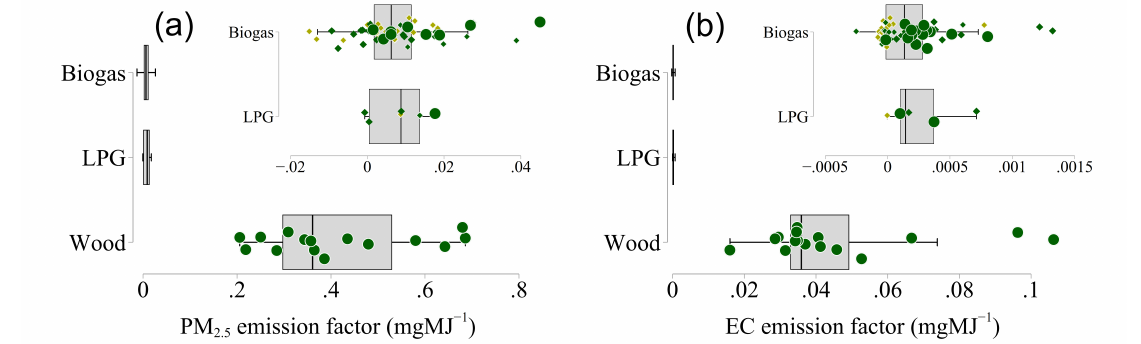
Figure 2. Box plots of PM 2.5 ( a ) and EC ( b ) emission factors. Boxes range from 25th to the 75th percentile and the middle bar is the median. Points show values for individual cooking events and are jittered vertically to reduce overlap between points. Large circles represent cooking events above both detection limits, LOD blank and LOD background , yellow diamonds are events below both detection limits, and the green diamonds are events under only one detection